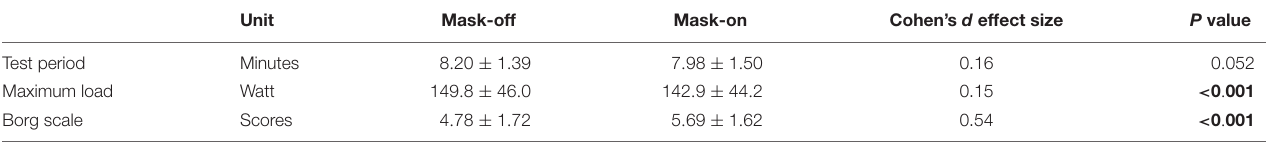
TABLE 2 | The comparison of cardiopulmonary exercise performance between mask-on and mask-off condition.